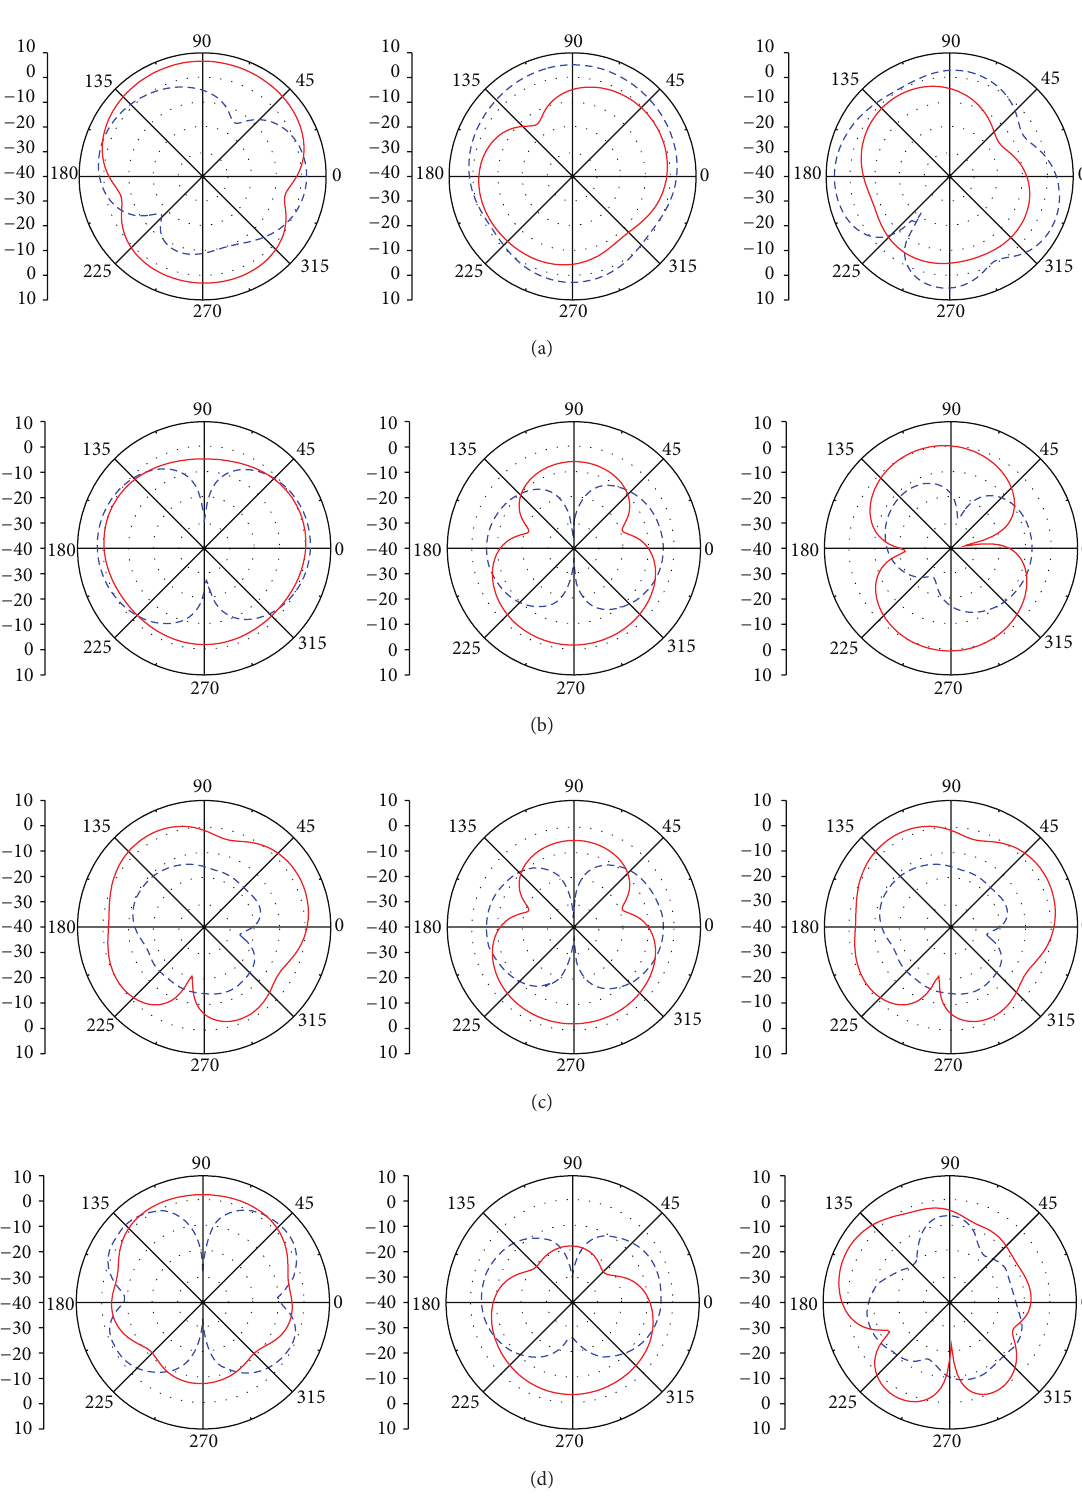
Figure 5: Measured 2D radiation patterns. (a) 750 MHz; (b) 925 MHz; (c) 1925 MHz; (d) 2350 MHz for the proposed filtering antenna (---------- 𝐸 𝜑 , ——— 𝐸 𝜃